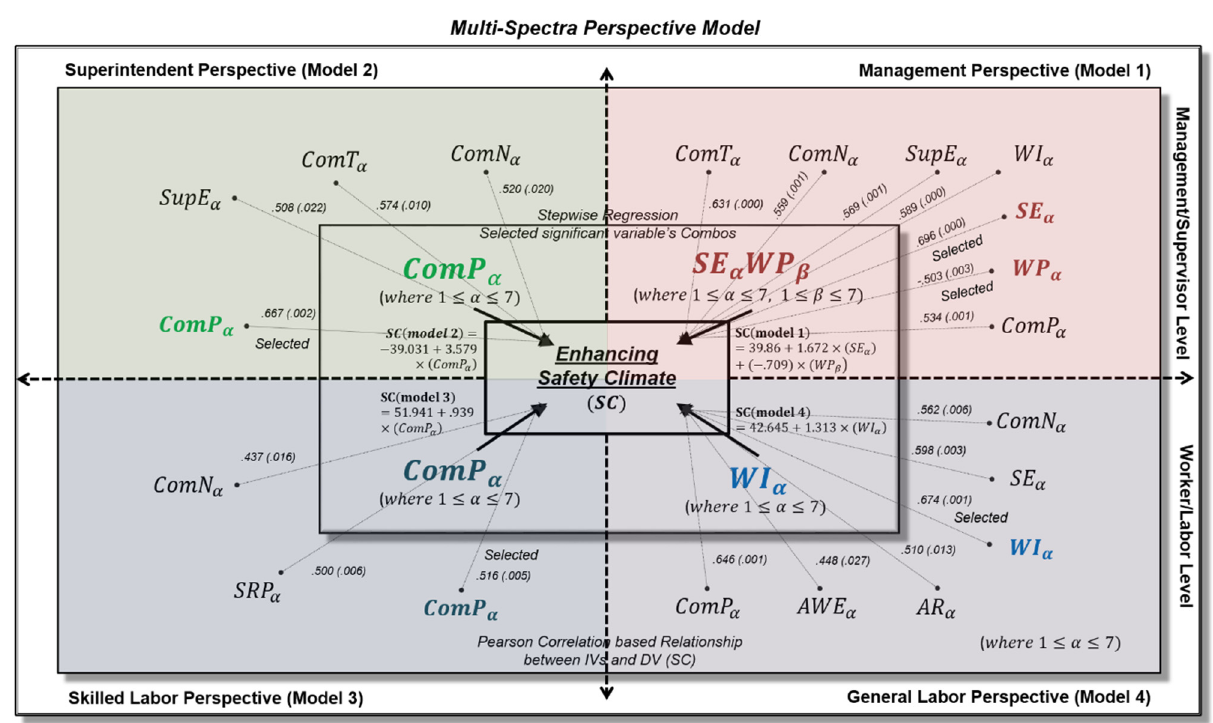
Figure 4. Multi-spectra perspective model.